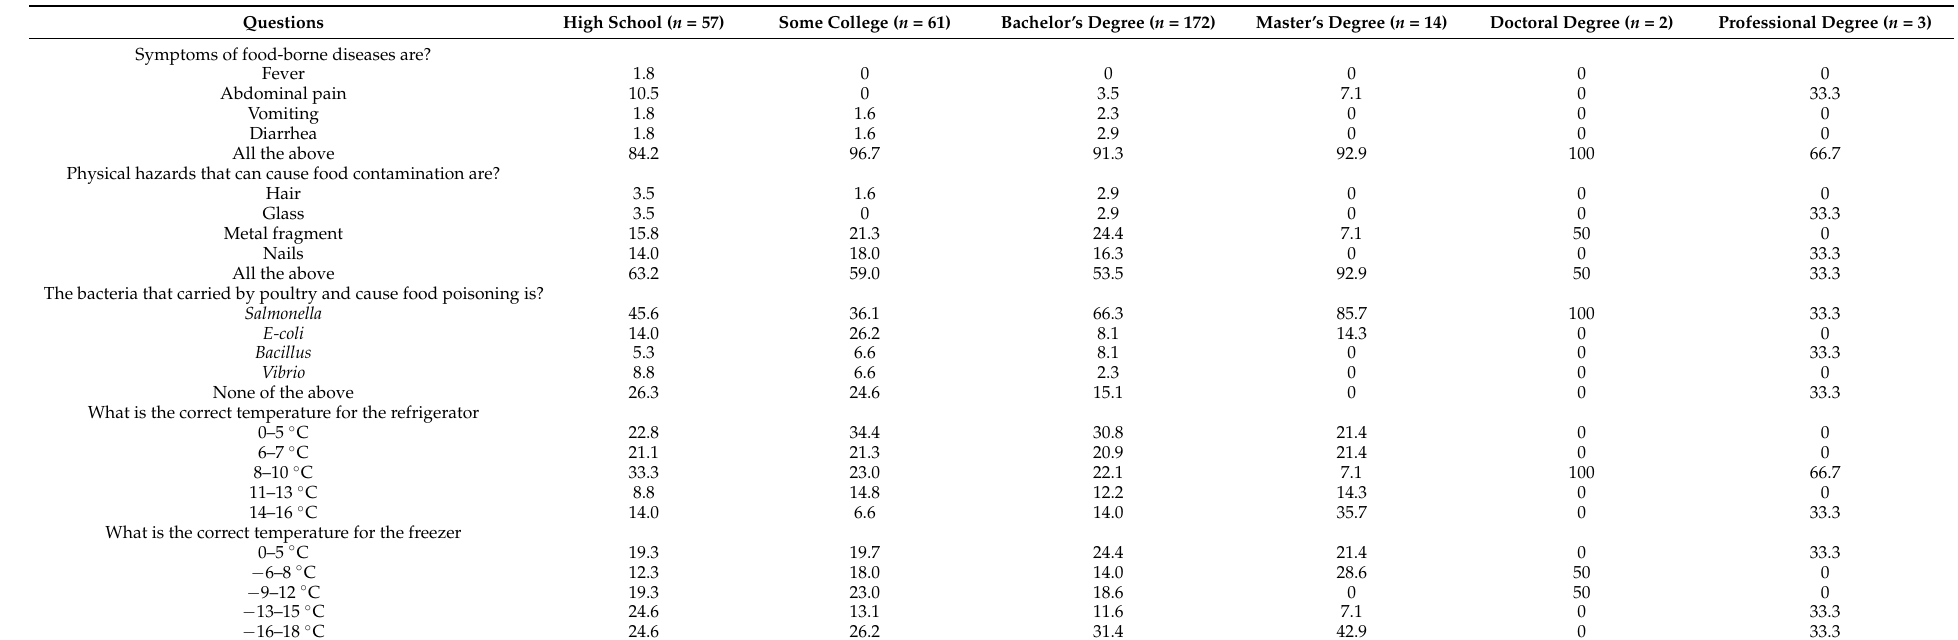
Table 3. Respondents’ food safety knowledge based on the education level.